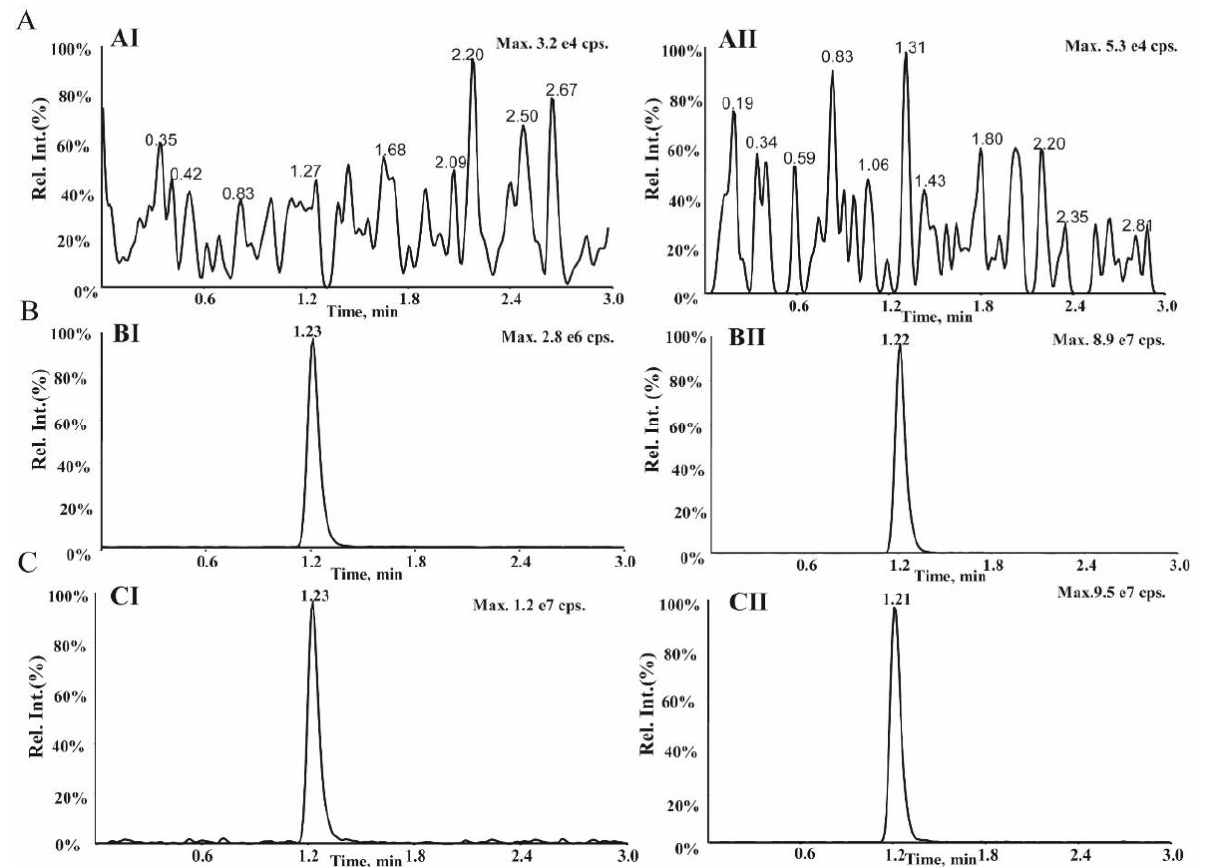
Figure 3. Representative LC ‐ MS 3 chromatograms of ( I ) AMT and ( II ) IS in ( A ) blank human plasma, ( B ) blank human plasma spiked with AMT at LLOQ (50 ng/mL) and IS (400 ng/mL), ( C ) actual plasma sample after oral administration of AMT.